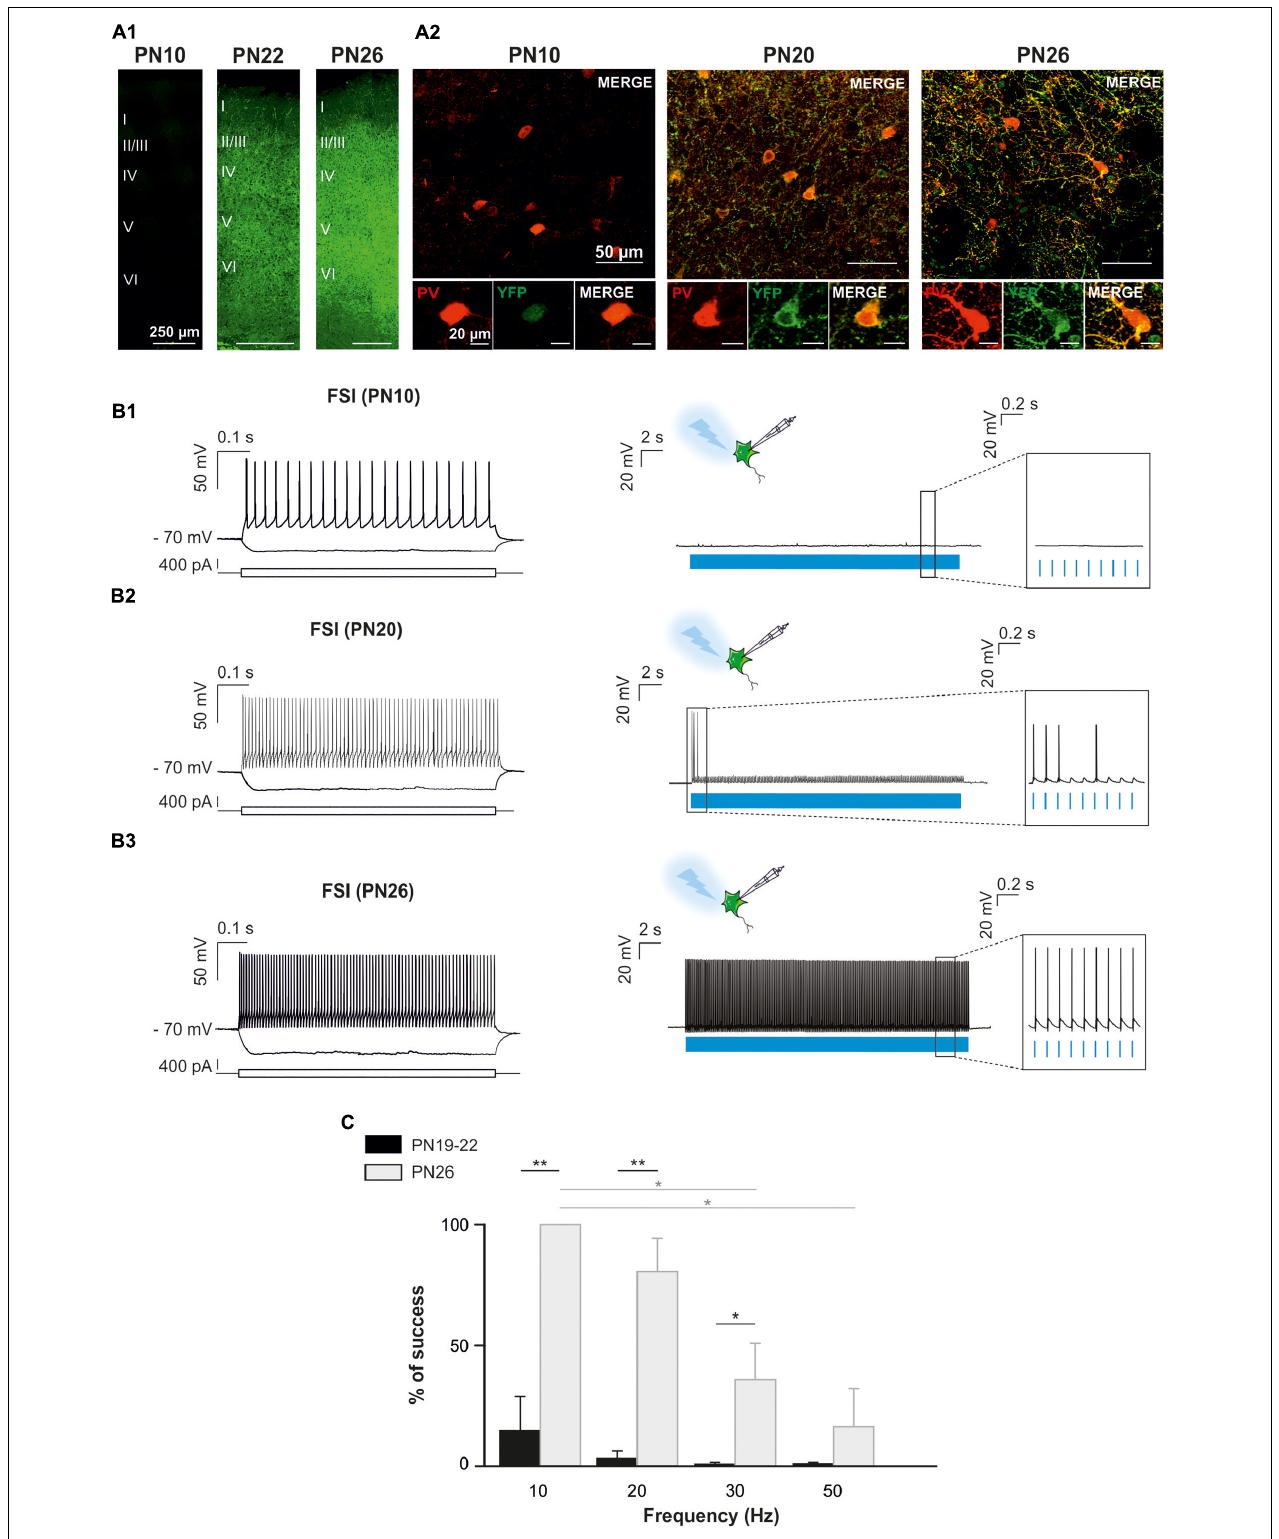
FIGURE 4 | Optogenetic stimulation of FSI in PV Cre :ChR2-YFP Lox / Lox mice during postnatal cortical development in brain slices. (A) Confocal images of cortical interneurons expressing ChR2 (YFP, green) and PV protein (red) at low (left) and high (right) magnifications at PN10, PN20 and PN26 mice. Note the faintly cytoplasmatic expression of YFP at PN10 compared to a brighter and more extensive membrane expression at later ages. (B) Current-clamp recordings of a layer V